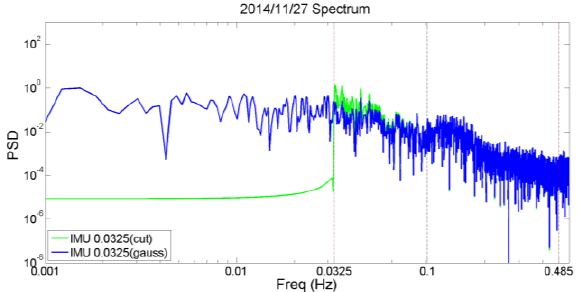
Figure 11(b). FFT power spectrum of IMU solutions by High- pass filter and Gaussian filter.